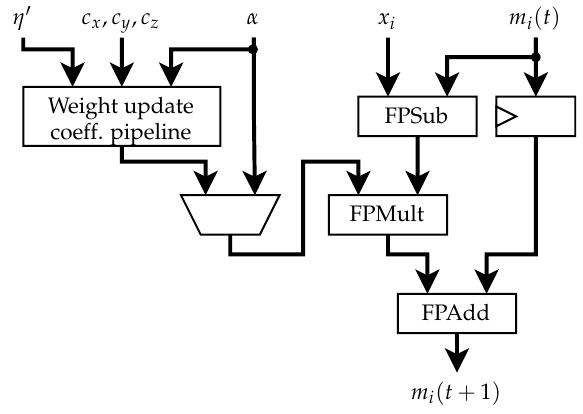
Figure 11. Weight update